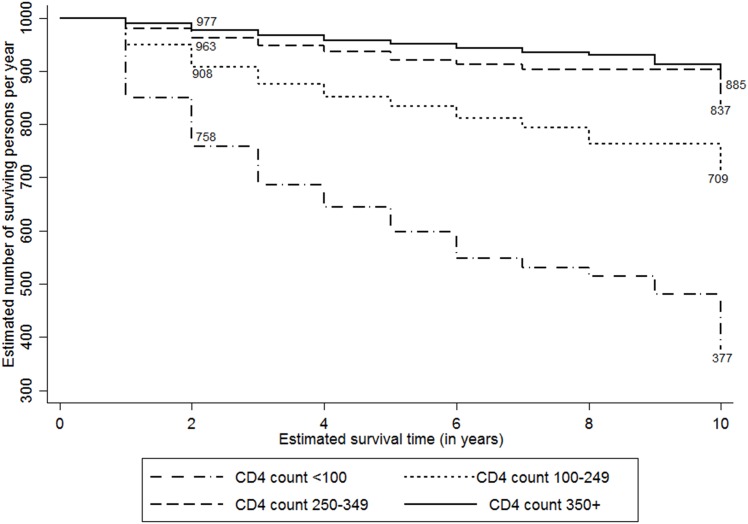
Adjusted Kaplan-Meier survival estimates by CD4 count (per 1000 persons per year).The line graph shows ten-year survival probability curves among PLHIV per 1000 persons per year since they tested positive for HIV by CD4 status. The estimates are adjusted by their place of residence. The CD4 staus is divided into four categories, i.e.CD4 count less than 100, CD4 count 100–249, CD4 count 250–349 and CD4 count 350 or more.